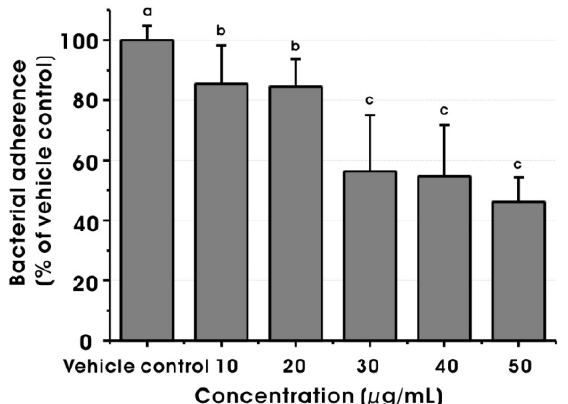
Figure 5. Effect of methanol extract of Dryopteris crassirhizoma root on sucrose-dependent adherence of Streptococcus mutans at sub-MIC levels. The data represent mean ± standard deviation. The vehicle control was 1% DMSO. Values followed by the same superscripts are not significantly different from each other ( p >